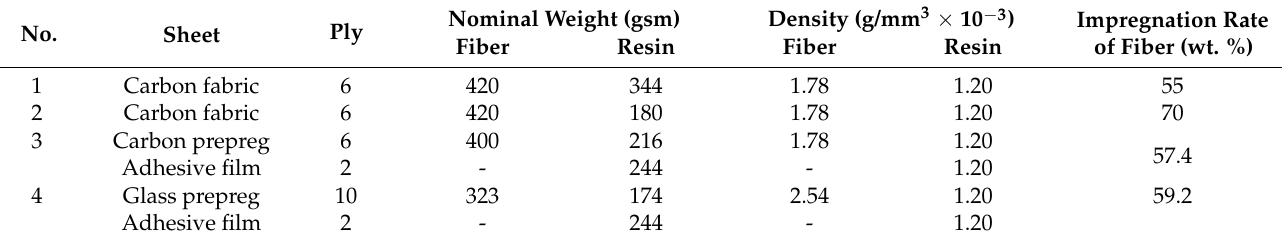
Table 1. Carbon and glass fiber-reinforced plastics (CFRP/GFRP) laminate properties.